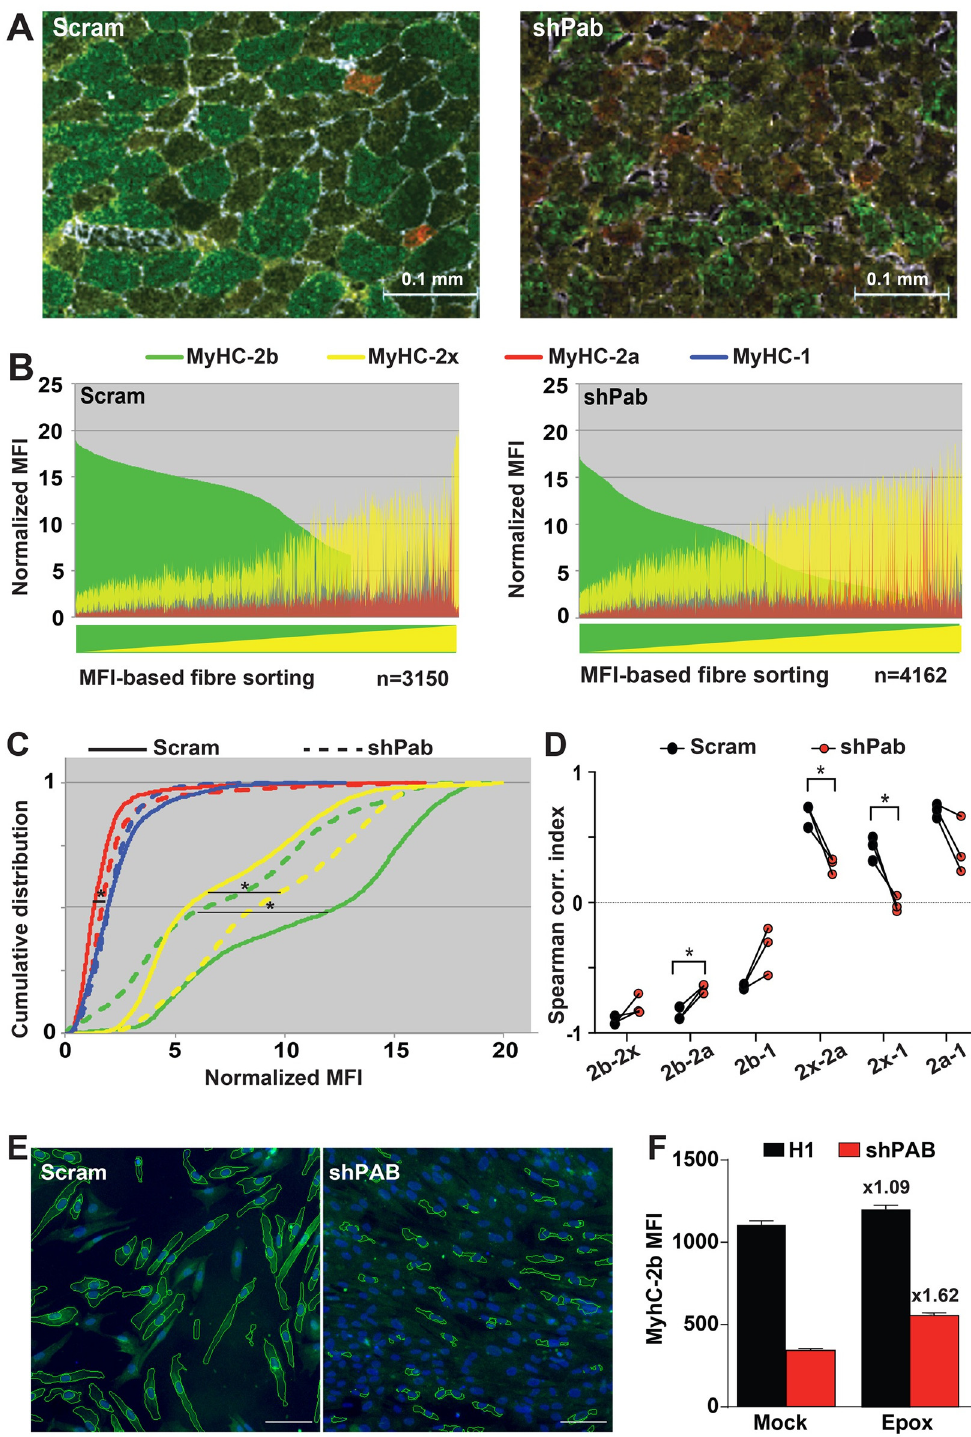
Fig 5. Papbn1-DR causes muscle fiber-type transition. A. Merged images of muscle cross sections stained with antibodies to four MyHC (type -2b in green; -2x in yellow; -2a in red; and type-1 in blue) isotypes and to laminin. Scale bar is 100 μ m. B. MFI distribution plots show the distribution of each MyHC isotype MFI per myofiber in Scram or shPab muscles. Distribution plots were made from N > 3000 myofibers. Myofibers were sorted by MyHC-2b (high to low) and MyHC-2x (low to high). C. Plots show cumulative distribution of MFIs of MyHC isotypes per myofiber between Scram and shPab muscles. D. Changes in Spearman correlation indices between two MyHC isotypes in shPab muscles as compared with the Scram muscles. Statistical significance was assessed by